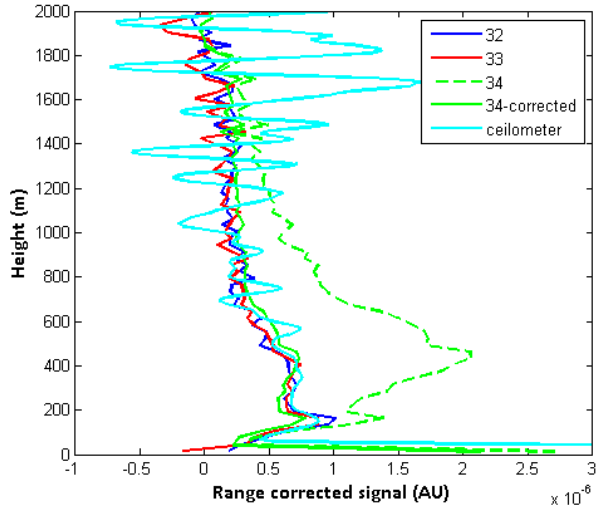
Fig. 5. Range-corrected signals from three Doppler lidars during the first inter-comparison campaign (04:18UTC on 9 September 2011). An appropriately scaled co-located ceilometer profile is also shown. Doppler lidars 32 and 33 agree with each other and the less-sensitive ceilometer. Doppler lidar 34 clearly has an incorrect focus; after the new telescope focus is applied, together with a suitable calibration factor, it agrees with the other instruments. Figure 6.